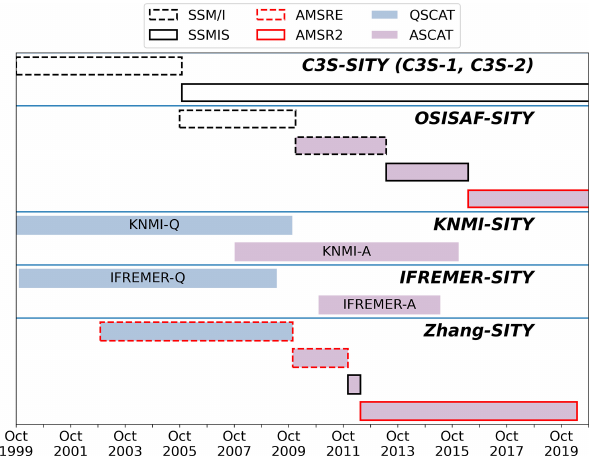
Figure 1. The timelines and satellite data input of eight SITY prod- ucts in this study based on five SITY retrieval